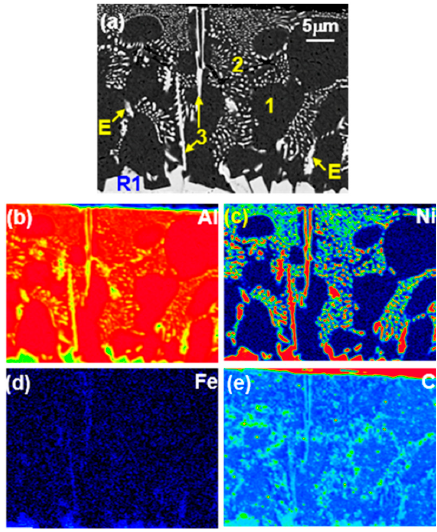
Figure 3. Electron-probe micro analyzer (EPMA) analysis results of specimen that was hot-dipped at 690 °C for 120 s: ( a ) back-scattered electron (BSE) Image; ( b ) Al; ( c ) Ni; ( d ) Fe; ( e ) C.